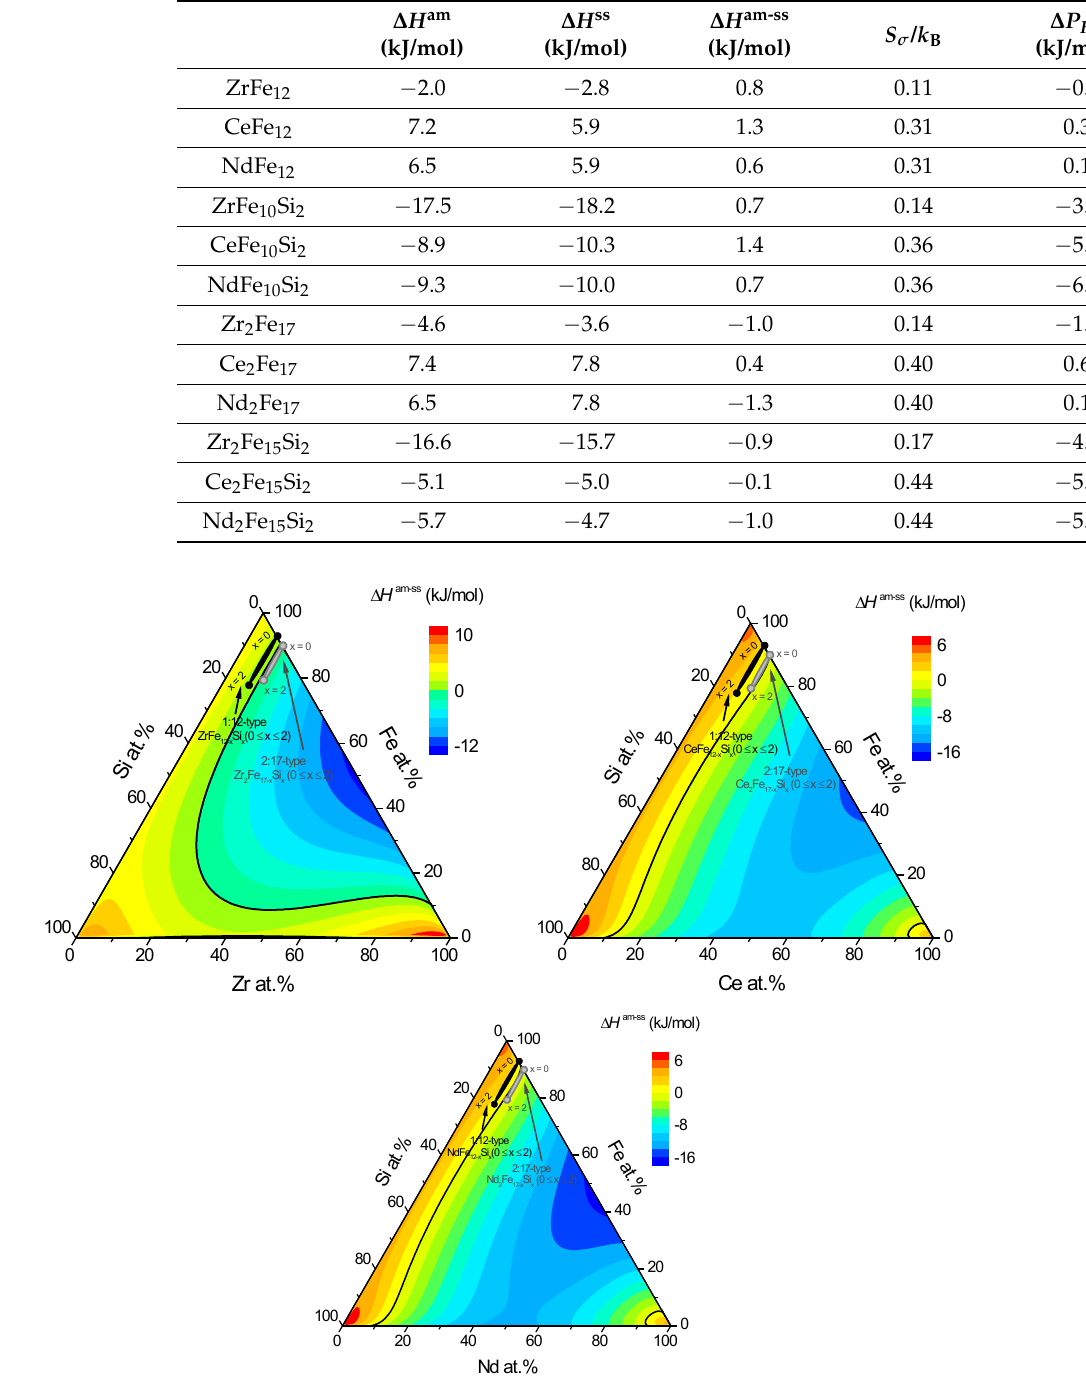
Figure 3. Compositional dependences of difference of two quantities, of formation enthalpies of amorphous phase and solid solution ∆ H am − ss of ternary (Zr, Ce, and Nd)-Fe-Si systems. Key composition regions are marked in grey (2:17-type phases) and black (1:12 type phases). Black solid lines are ∆ H = 0 kJ/mol indicators (negative ∆ H am − ss values indicate a lower enthalpy of formation amorphous phase).